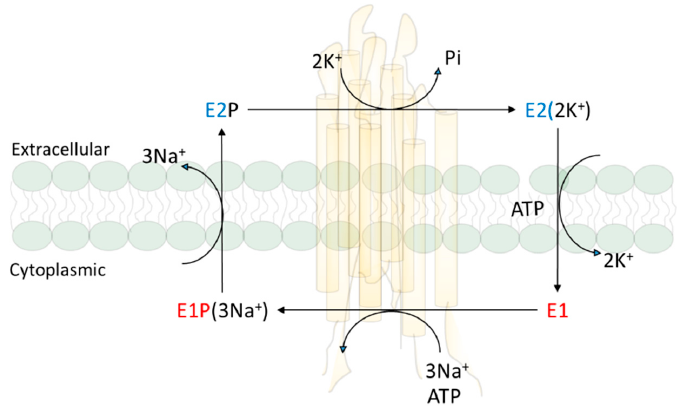
Figure 1. Schematic presentation of Albers–Post reaction mechanism.